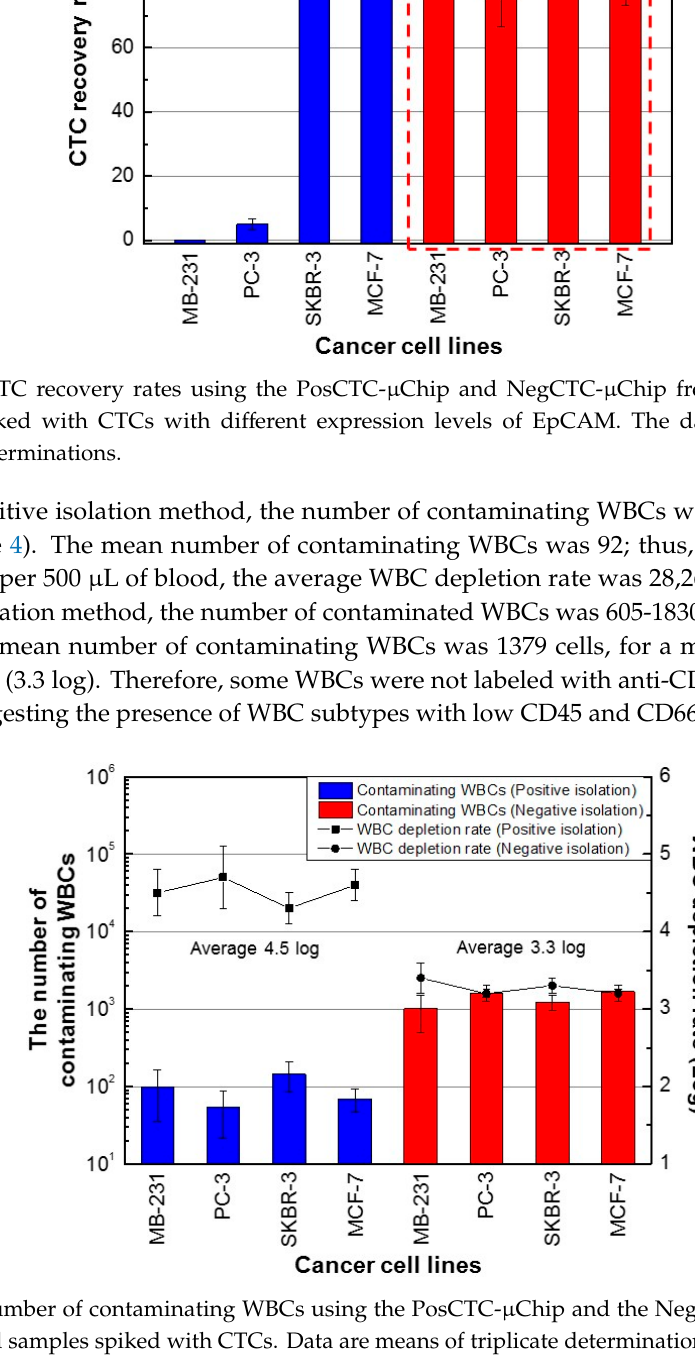
Figure 5. Purity of cancer cells isolated using the PosCTC- μ Chip and the NegCTC- μ Chip from 500- μ L blood samples spiked with the CTCs. Data are means of triplicate determinations. 4. Conclusions We compared an EpCAM-based positive isolation method and a CD45/CD66b-based negative isolation method, using MDA-MB-231, PC-3, SKBR-3, and MCF-7 cancer cells, which have different surface expression levels of EpCAM. The recovery rates of the positive isolation method increased with increasing EpCAM expression level. In contrast, the negative method enabled isolation of cancer cells from blood samples with an average recovery rate of 83.1%, irrespective of the expression level of EpCAM. Therefore, the negative isolation method yielded a larger quantity of CTCs from blood samples than the positive method, irrespective of their EpCAM expression level. WBCs were also